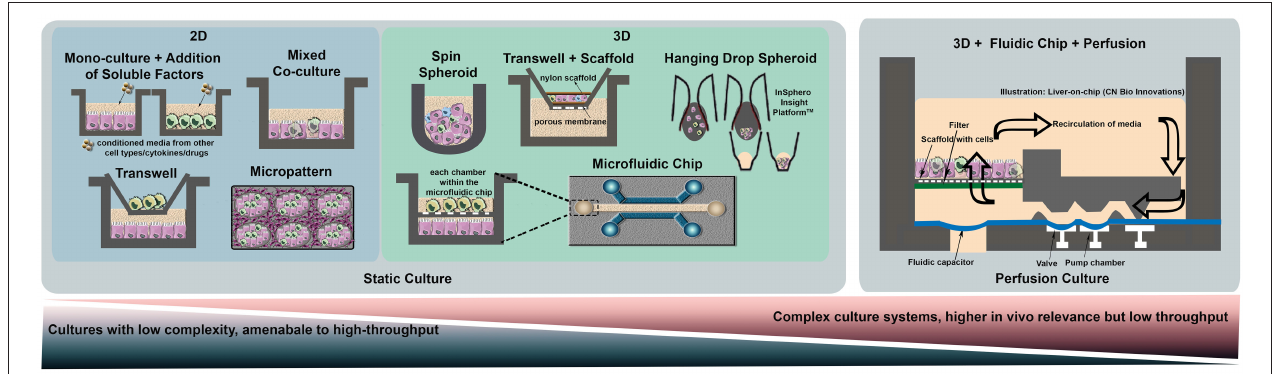
FIGURE 1 | Selection of simple and complex models used for in-vitro liver co-cultures. On the left-hand side, various platforms for static cultures are presented, ranging from simple co-cultures in multi-well plates to more complex systems such as microtissue (hanging drop method), micropatterned surfaces, 3D spheroids formed using scaffolds or microfluidic chips. On the right-hand panel, a macroscopic 3D culture on a chip incorporating a perfusion system is represented using the bioreactor developed by CN Bio Innovations.